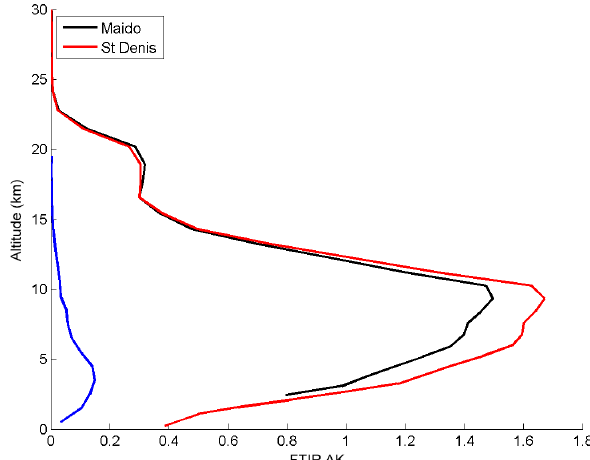
Figure 11. Mean total column AK for the FTIR ground-based mea- surements over Maido (black) and Saint-Denis (red) at La Réunion. Both stations are shown by green stars in Fig. 1. Both FTIR stations have a degree of freedom for signal close to 1. As reminder, the mean normalized Jacobian from Fig. 2 is plotted in